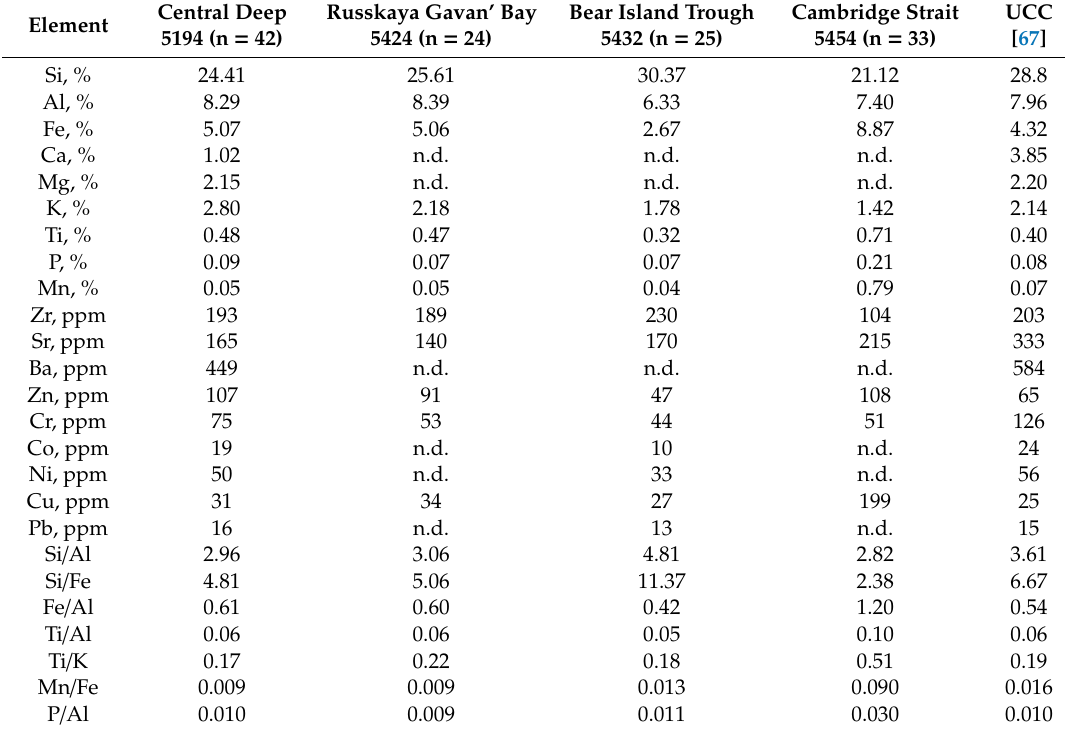
Table 7. Average contents and ratios of elements in sediment cores AMK-5194, -5424, -5432, and -5454 in comparison to the Upper Continental Crust (UCC)